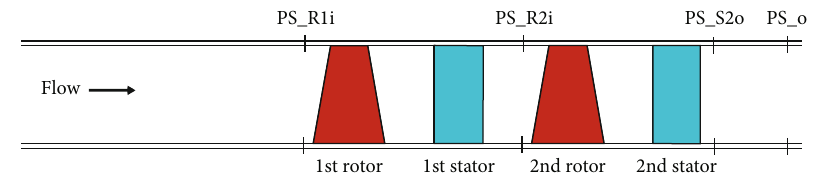
Figure 5: Sensor arrangement sketch of the high-speed axial compressor.